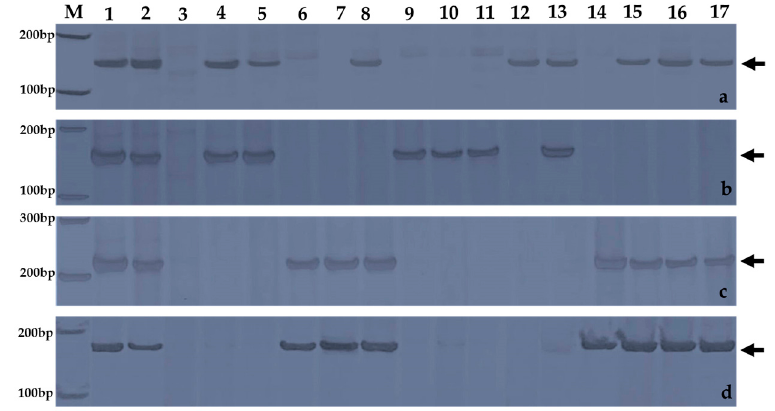
Figure 3. Amplification patterns of wheat- A . cristatum homozygous materials using 6P-specific STS